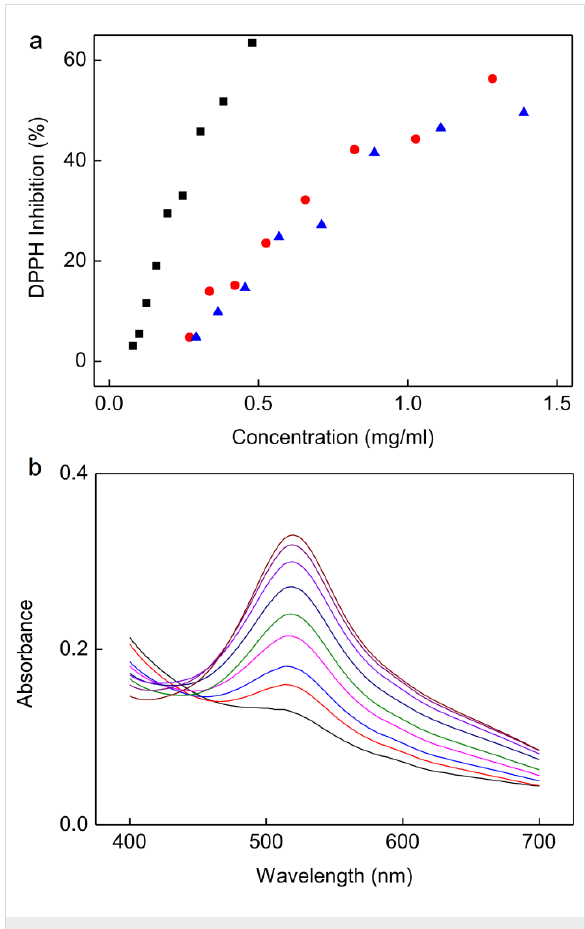
Figure 4: Free radical scavenging of the phenolic compound-modified particles. (a) Inhibition as a function of the concentration of γ -Fe 2 O 3 @Hep-CS-G (black squares), γ -Fe 2 O 3 @Hep-CS-H (red circles), and γ -Fe 2 O 3 @Hep-CS-P particles (blue triangles) according to the DPPH assay and (b) absorbance of DPPH solution with the γ -Fe 2 O 3 @Hep-CS-G colloid of different concentrations (0.08–0.50 mg/mL); DPPH: